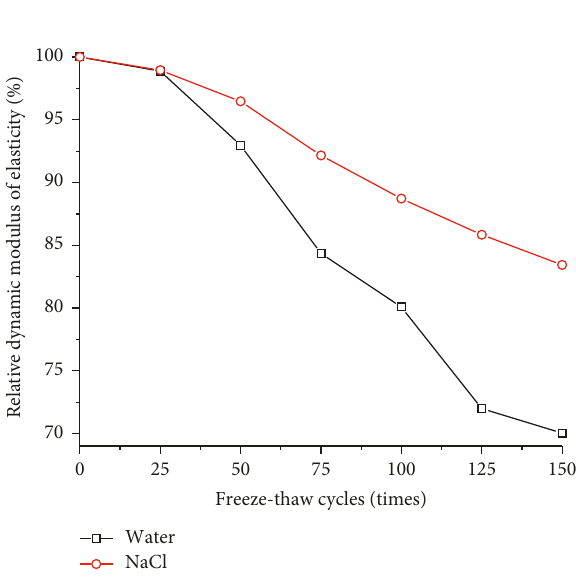
Figure 7: Relative dynamic modulus of elasticity.